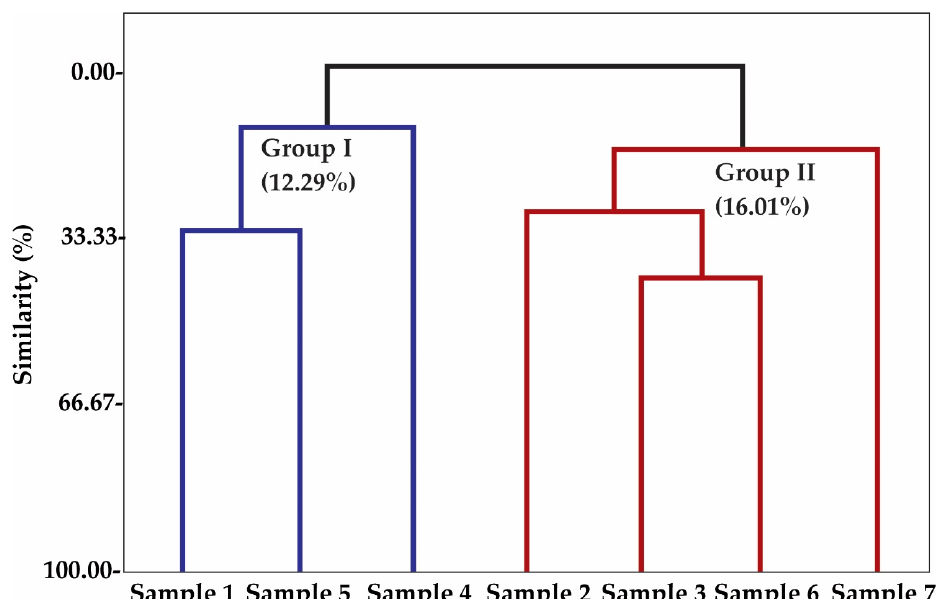
Figure 3. Biplot (PCA) from the analysis of volatile compounds identified in the aromas of seven samples of bee propolis from Apis mellifera .